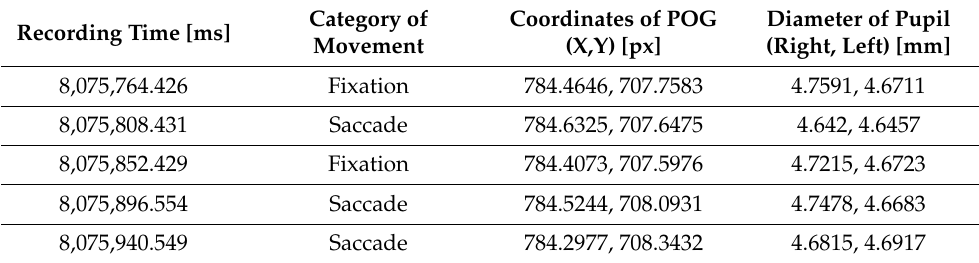
Table 1. Samples of the of eye-tracking